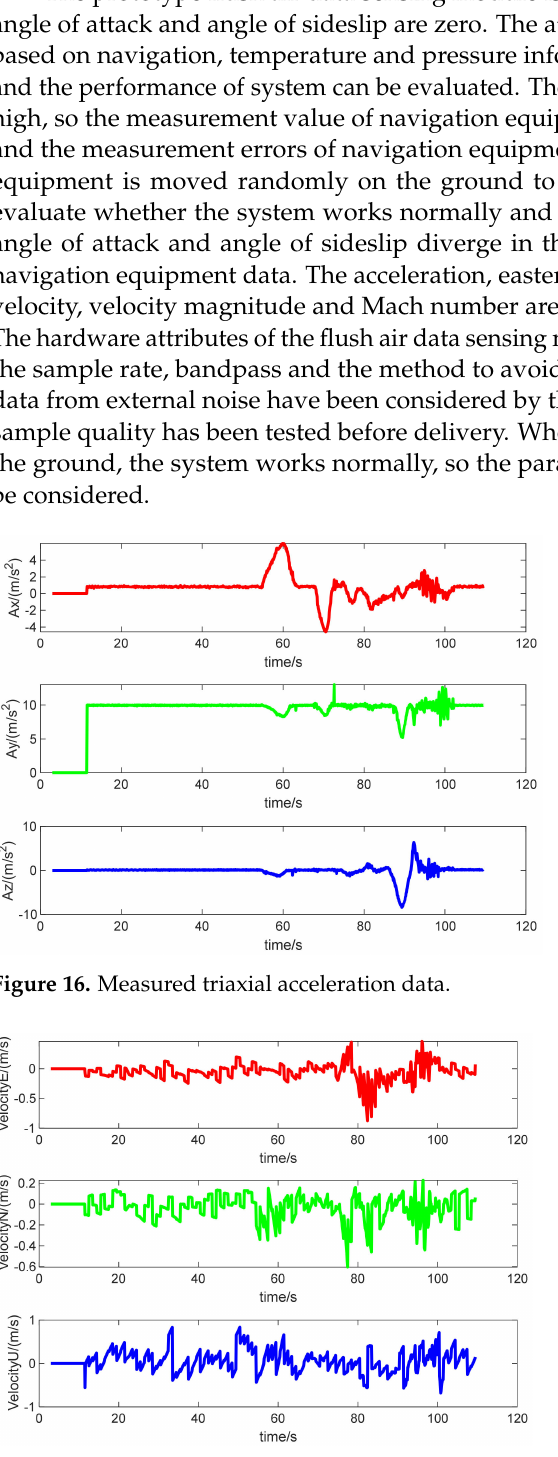
Figure 17. Measured integrated velocity